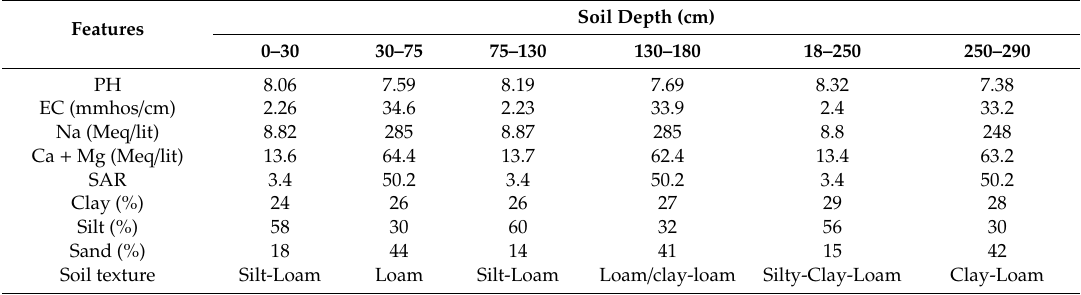
Table 1. Physical and chemical properties of soil in the gullies of Shirahan